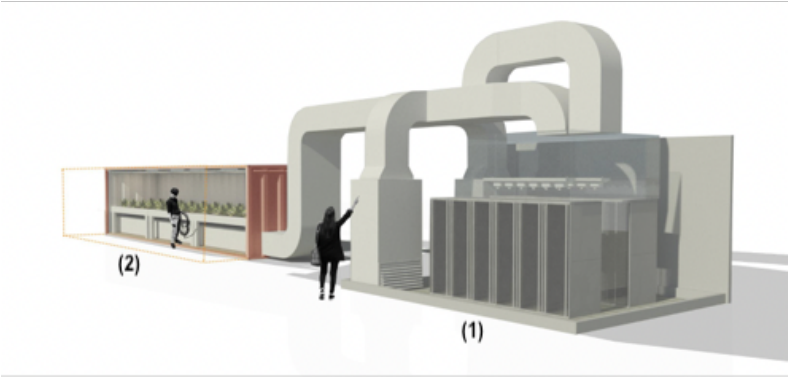
Figure 1. Example illustration of edge data center (1) heat reuse for a small urban greenhouse (2).